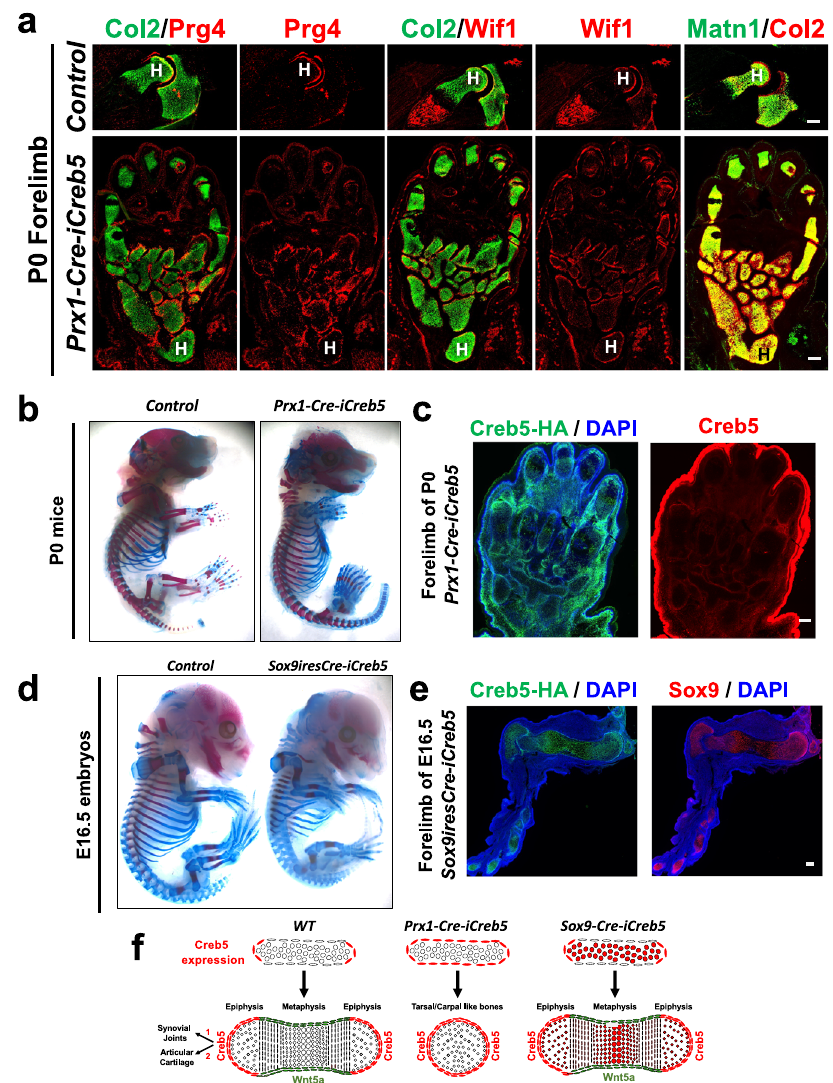
Fig. 7 | Misexpression of Creb5 in all limb bud mesenchymal cells, but not in Sox9-expressing cells, profoundly blocks longitudinal growth in the stylopod andzeugopodcartilageelementsandinducestheperichondriumtodevelopas articularcartilage.a GeneexpressionassayedbyFISHinserialsectionsofforelimbs from either a P0 Prx1-Cre-iCreb5 mouse or a control littermate. Humerus (H) is indi- cated. b Alcian Blue/Alizarin Red whole mount staining of either a P0 Prx1-Cre-iCreb5 mouseoracontrollittermate(thatlackseitherthe Prx1-Cre orthe Rosa26 iCreb5-HA allele). c Immuno fl uorescence detection of either iCreb5-HA (Prx1-Cre) (green), endogenous and exogenousCreb5(red)andDAPI(todetectnuclei)inserialsectionsoftheforelimbof a P0 Prx1-Cre-iCreb5 mouse. Red fl uorescent signal in ectoderm (in right-most image) isanartifactandwasalsoobservedintheabsenceofanti-Creb5. d